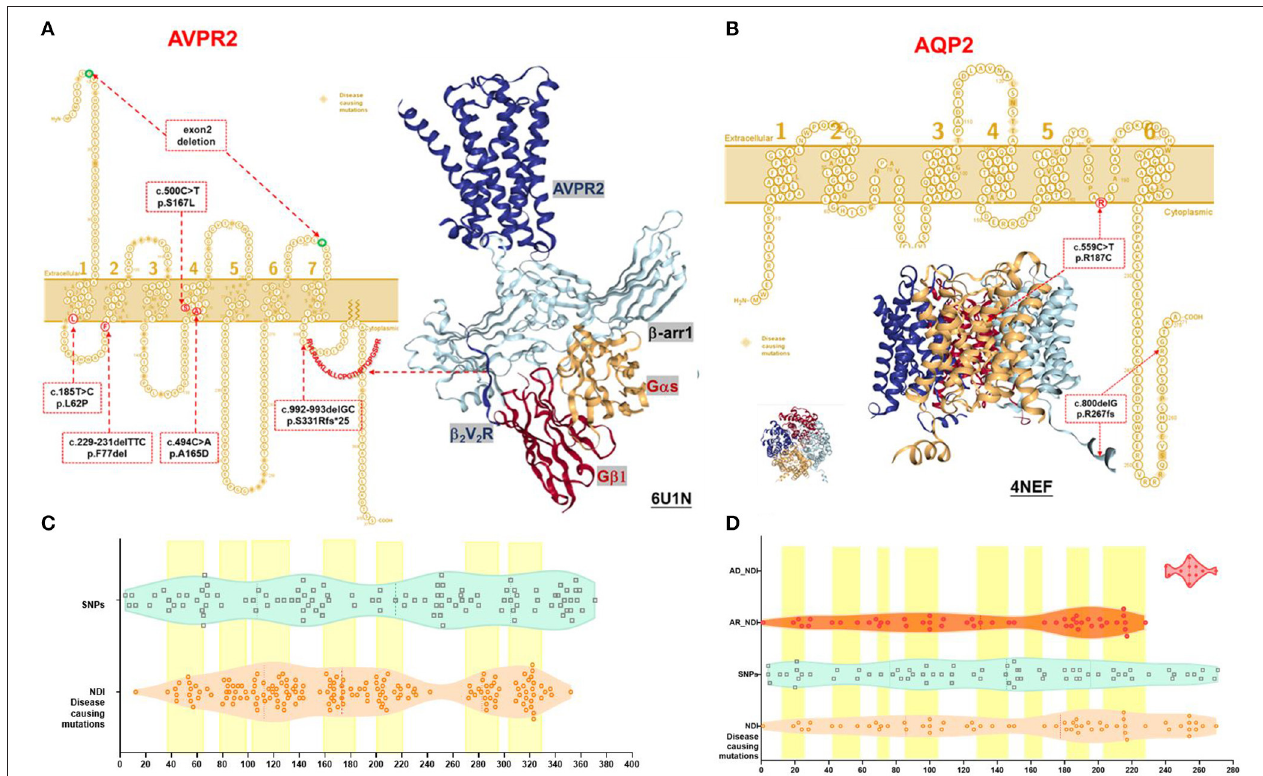
FIGURE 1 | Schematic representation and protein structure of AVPR2 and AQP2 protein with location of mutations. (A) AVPR2, which belongs to the G-protein-coupled receptor (GPCR) superfamily, is formed by 371 amino acids with seven transmembrane, four extracellular, and four cytoplasmic domains, and is present at the basolateral membrane (UniProtKB P30518-1, P30518-2) ( 14). The seven transmembrane domains with the extracellular NH2 terminus and its intracellular COOH terminus are illustrated as originally reported. Ribbon diagram of AVPR2 from PDB entry 6U1N was shown with GPCR- β arrestin structure in lipid bilayer. The six mutations identified in our NDI cohort were indicated in the red dotted box, and the diagnostic mutations by HGMD were labeled in the orange diamond. (B) AQP2, which belongs to the larger family of major intrinsic proteins, is formed by 271 amino acids. Aquaporins contain two tandem repeats, each containing three transmembrane α -helices domains with the amino and the carboxyl termini located on the cytoplasmic surface of the membrane (UniProtKB P41181) ( 15). The six transmembrane domains with the intracellular NH2 and COOH terminus are illustrated as originally reported. Ribbon diagram of AQP2 from PDB entry 4NEF was shown with side and top view. The two mutations identified in our NDI cohort were indicated in the red dotted box, and the diagnostic mutations by HGMD were labeled in the orange diamond. (C) A violin plot revealed the domain composition of AVPR2 with the location of the 109 population variants (SNPs) from gnomAD (turquoise square) and the 169 diagnostic mutations from HGMD (peachpuff circle). The seven transmembrane regions were labeled as a yellow box. There was a significant enrichment of diagnostic mutations in the transmembrane regions (Fisher test, P = 0.001). (D) A violin plot revealed the domain composition of AQP2 with the location of the 70 population variants (SNPs) from gnomAD (turquoise square) and the 62 diagnostic mutations from HGMD (peachpuff circle) including 56 mutations inherited by autosomal recessive trait (AR, orange circle) and 6 mutations inherited by autosomal dominant trait (AD, scarlet dot). The eight transmembrane regions were labeled as a yellow box. There was no significant enrichment of diagnostic mutations in transmembrane region compared with population variants (Fisher test, p = 0.079). The mutations by AD were more likely located in the C-terminal region compared with that by AR (Pearson test, p =